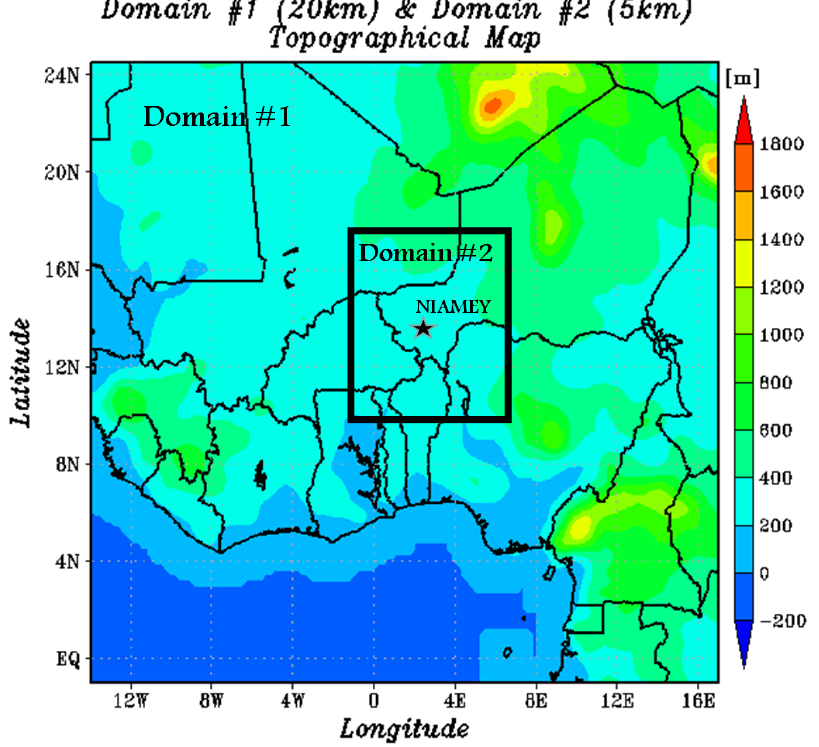
Figure 2. Mesoscale model